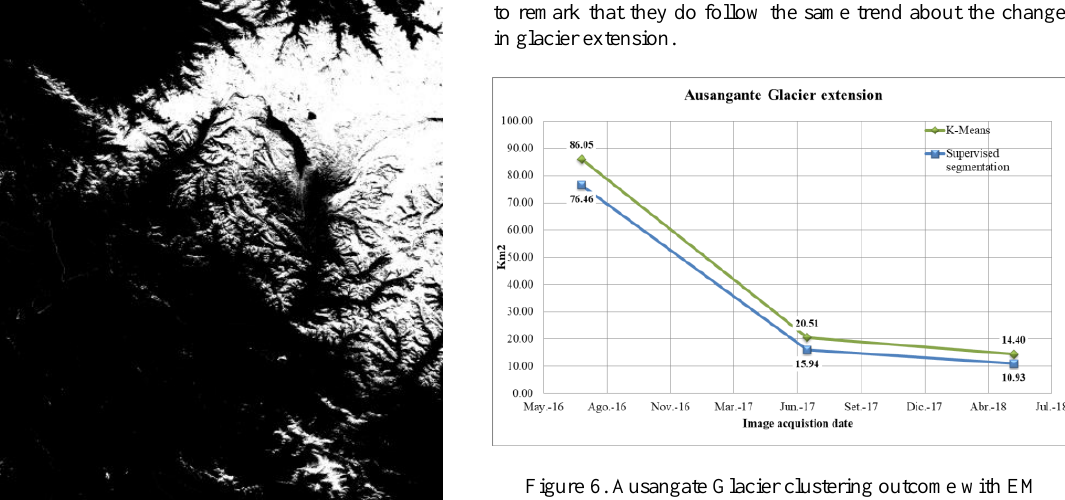
Figure 6. Ausangate Glacier clustering outcome with EM algorithm.